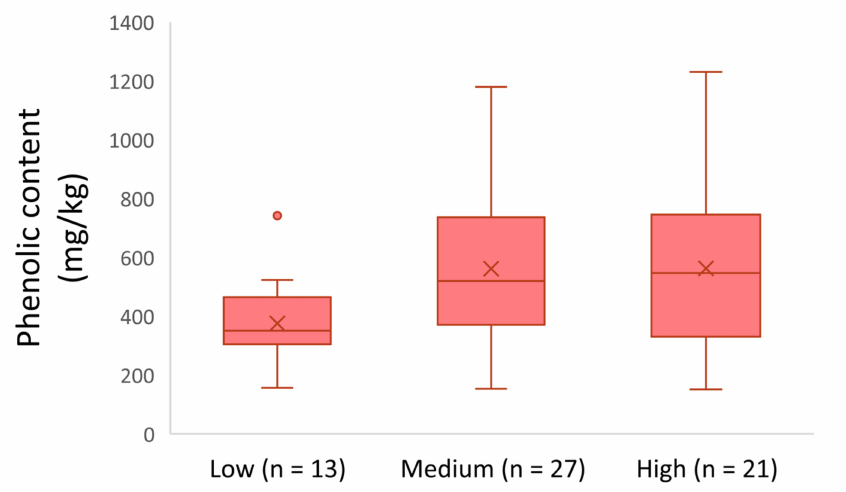
Figure 4. Phenolic content of the analyzed EVOOs produced in 2017–2018 with respect to